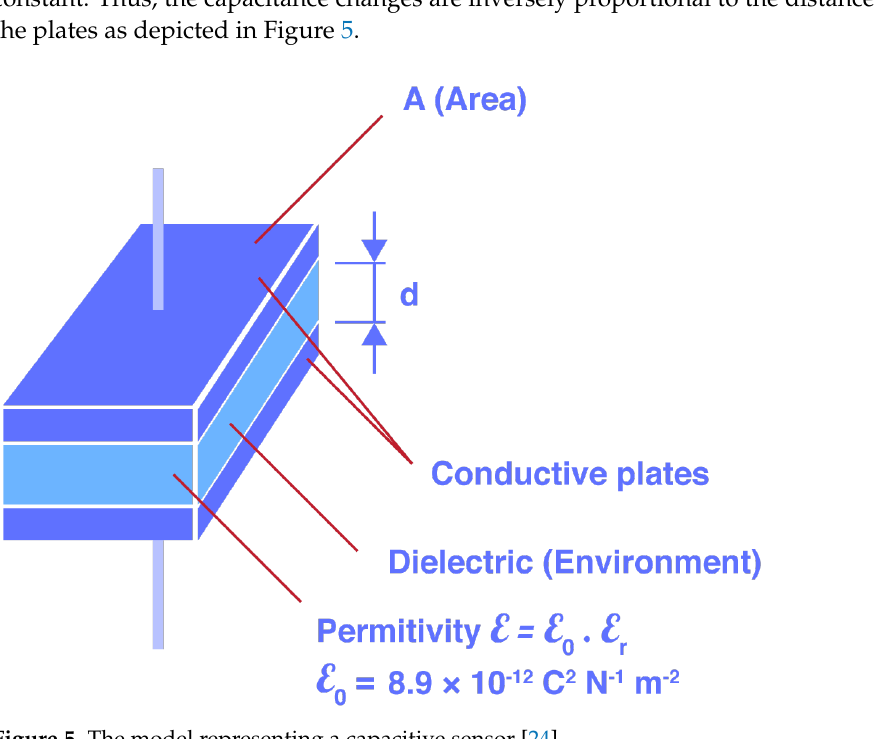
Figure 5. The model representing a capacitive sensor